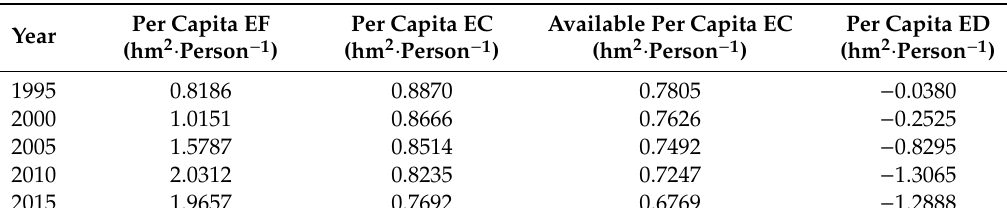
Table 6. Trends in the per capita EF, EC, and ecological deficit (ED) in northwestern Guangxi from 1995 to 2015.